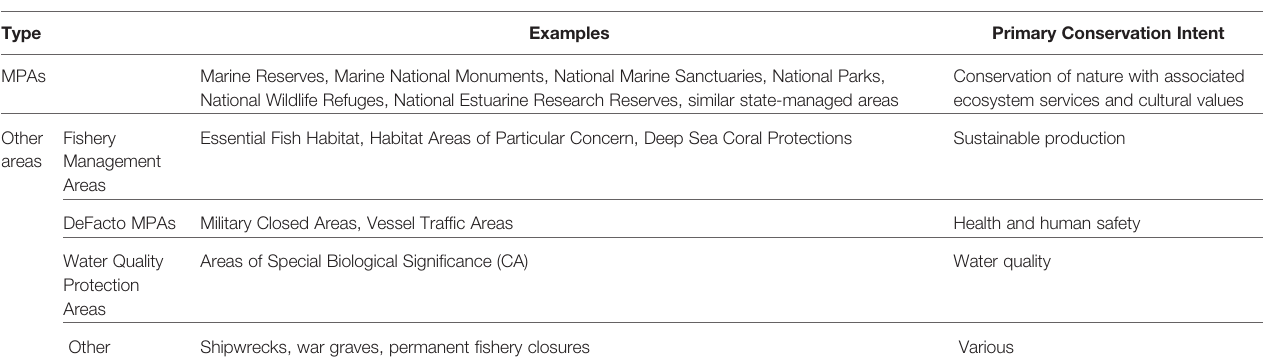
TABLE 1 | Types of area-based management in U.S.